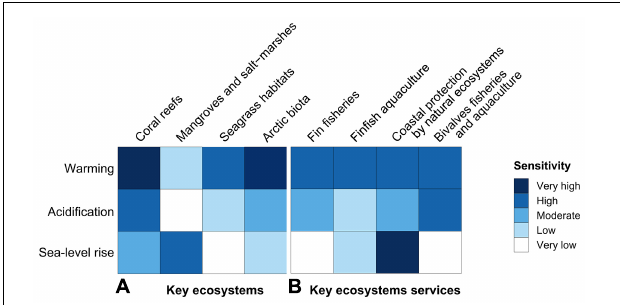
FIGURE 1 | Sensitivity of key ecosystems (A) and ecosystem services (B) to key climate-related drivers. The scores of this expert assessment and their justification are provided in section “SM3.3” of the Supplementary Materials